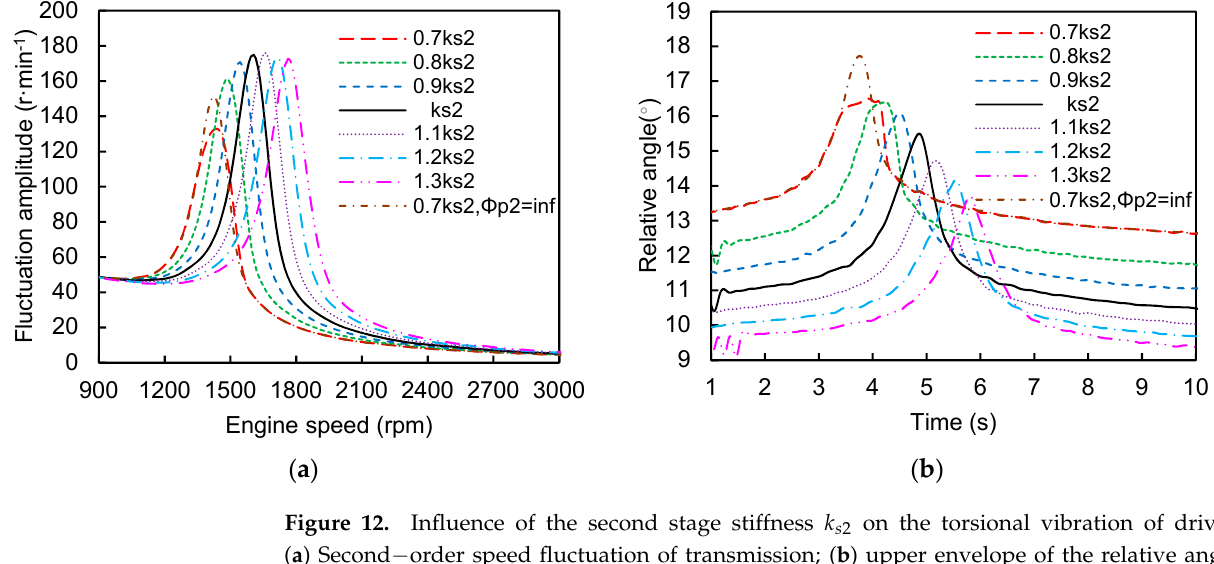
the clutch (baseline: the black solid curve).